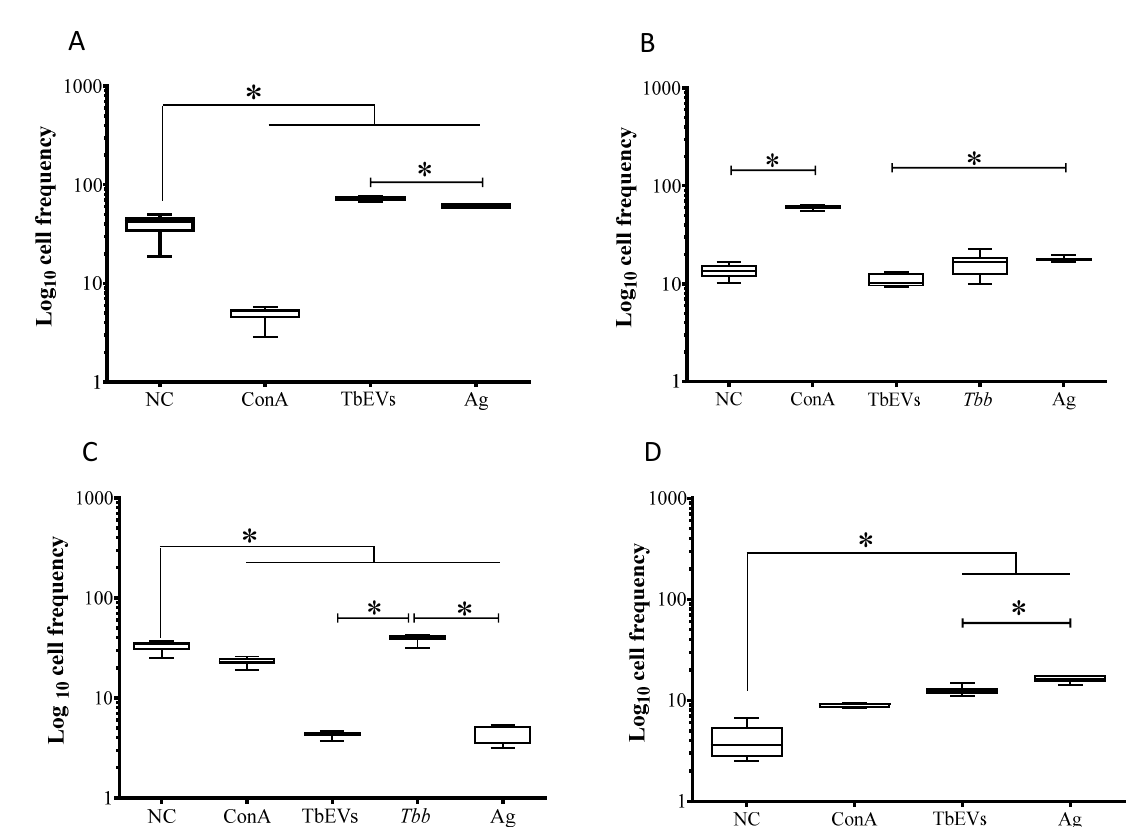
Figure 8. Differentiation of CD25 + and FoxP3 + CD4 + T cell subsets induced by T. b. brucei EVs. CD4 + cell fraction exposed to T. b. brucei parasites ( Tbb ), stimulated by Ag, TbbEVs, and ConA, and unprimed cells (negative control, NC) were labelled with CD3, CD25 and FoxP3 monoclonal antibodies and evaluated by flow cytometry. CD3 + cells were gated and the frequency of CD25 + FoxP3 + ( A ), CD25 − FoxP3 − ( B ) CD25 + FoxP3 − ( C ) and CD25 − FoxP3 + ( D ) cell subsets were estimated. In consequence of the low levels of CD3 + cells, the frequency and density of FoxP3 were not considered in T. b. brucei exposed-PBMC. Results of three independent experiments ( n = 18) performed in duplicate are represented by whiskered box-plot, median, minimum, and maximum values. The non-parametric Wilcoxon matched-pair signed-rank test was used for statistical comparisons. * ( p < 0.05) indicated significant differences.